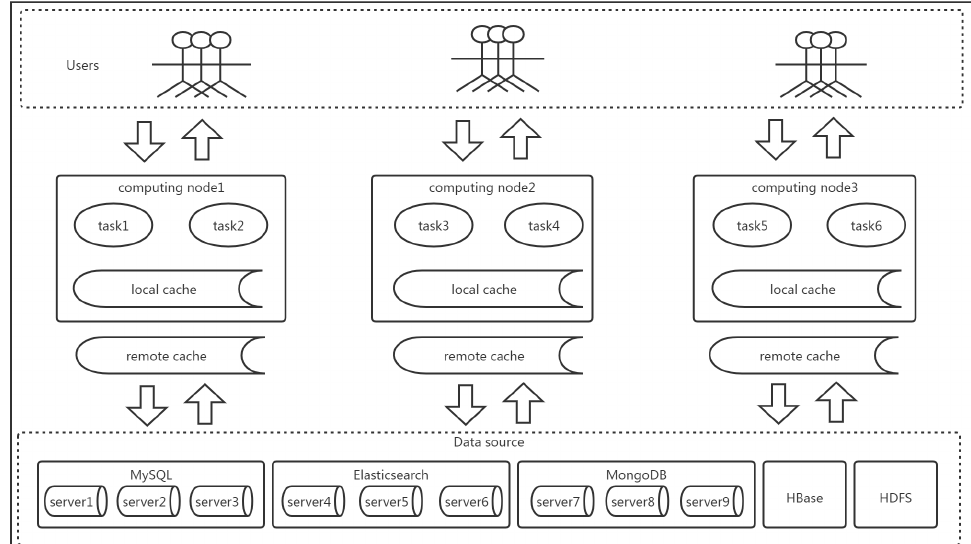
Figure 1. Adding a cache layer to Spark